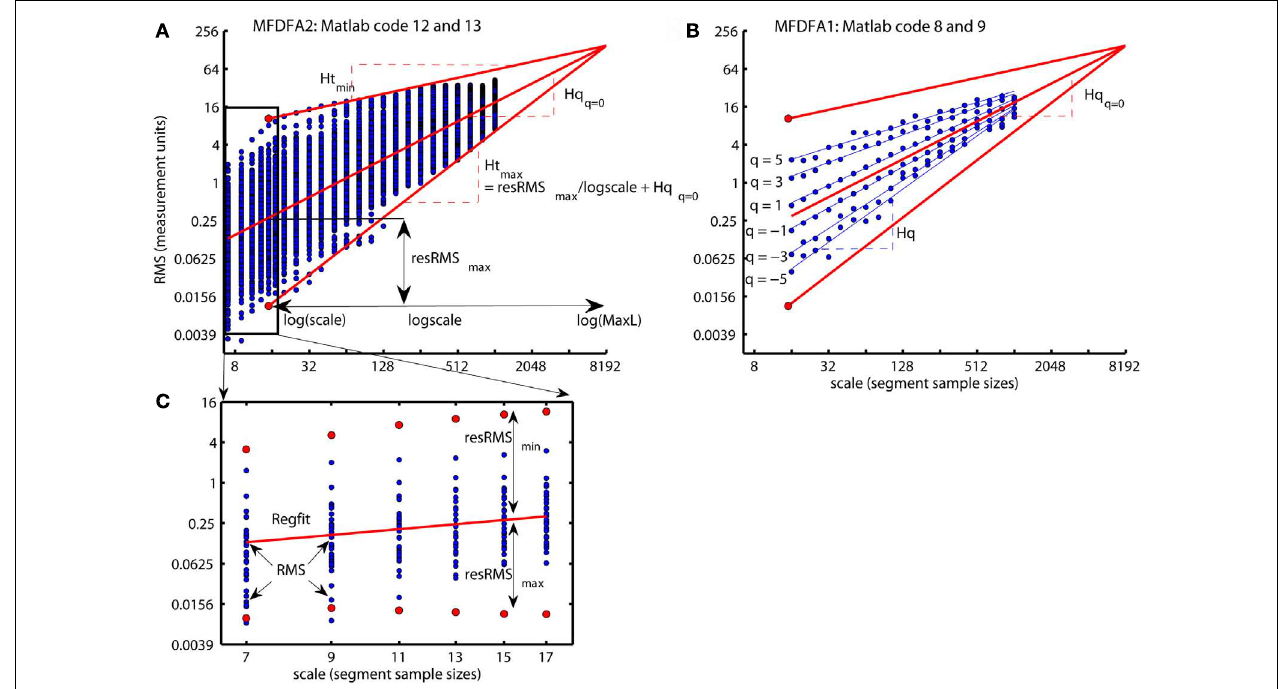
FIGURE 12 | (A) A summary of how the local Hurst exponent Ht is estimated in Matlab code 13.The regression line Regfit (red center line) is the center of the spread of local RMS in log-coordinates and is equal to the regression line qRegLine{q == 0} in Matlab code 8 and 9 [see (B) ].The minimum and maximum local Hurst exponent Ht(5,:) is the slope of the upper and lower red lines, respectively, that converge from the maximum and minimum of RMS{5} onto the regression line Regfit at the maximum scale maxL . Consequently, the local Hurst exponent Ht(ns,:) estimated by dividing the residual resRMS{ns}(v) for each time instant v by logscale(ns) (i.e., the difference between the maximal scale maxL and scale(ns) in log-coordinates) and adding the slope Hq q = 0 of the regression line Regfit .